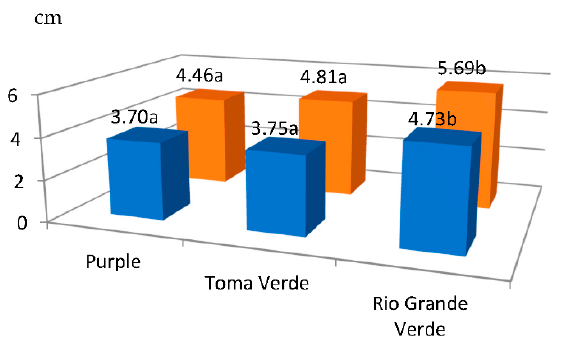
Figure 4. The effects of cultivar, plant covers and soil mulching on the vertical and horizontal